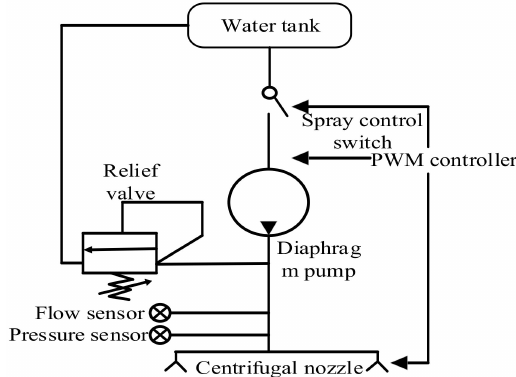
Figure 14. Composition of spray